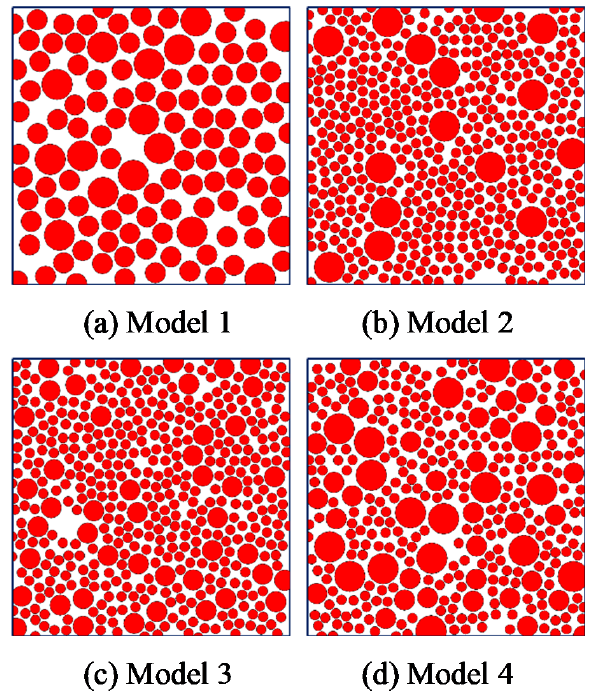
Figure 5. Mesoscale filling model of propellant with different particle sizes.